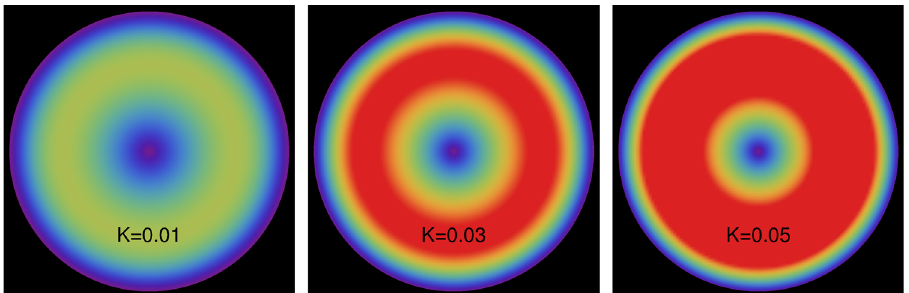
Fig. 2 Radial pressure [ 6 ˜ p ( r ) × 10 3 ] for three r different values of K and n = 2. Note that the pressure decreases monotonically form the center (red colored regions) towards the surface (violet colored region)